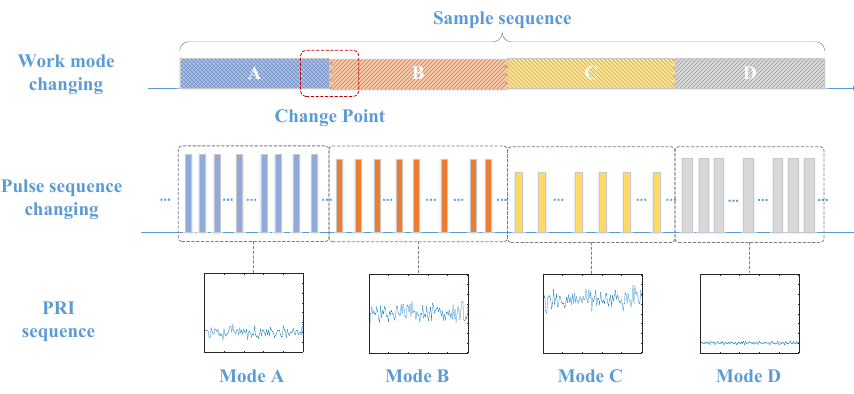
Figure 1. Illustration of PRI sequence with fine-grained MFR work modes